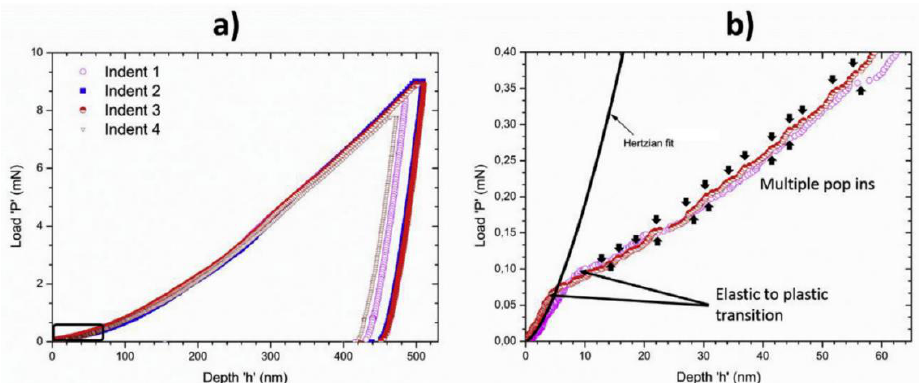
Figure 31. The ( a ) load vs. displacement curves for four different indents that were made inside the body-centered-cubic (BCC) grain in the HEA over indentation depths of 0 to 500 nm, and the ( b ) highlighted region, which shows the data for two randomly selected indent curves. Here, the graph features the elastic to plastic transition and contains multiple pop-ins (reproduced from Reference [292] with permission).